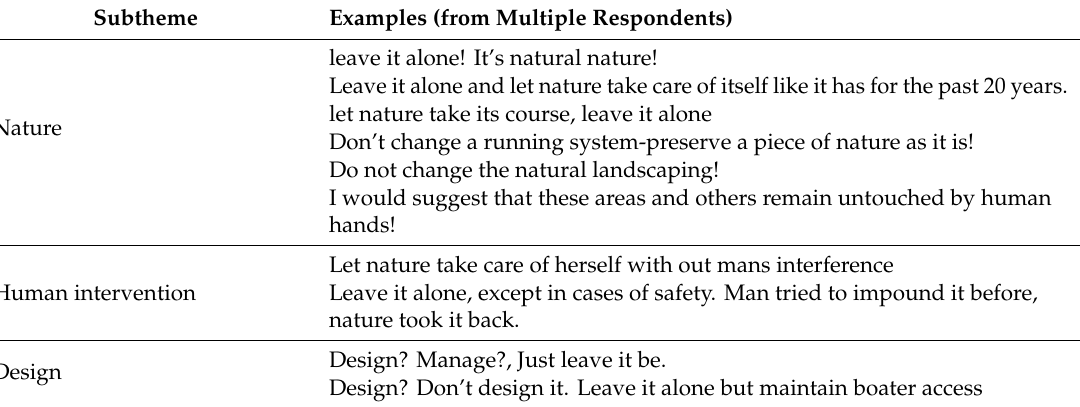
Table 2. Select sampling of “leave it alone” survey